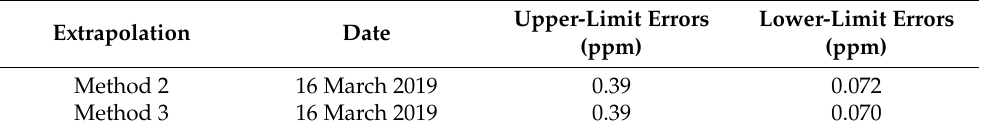
Table 6. The estimation of uncertainty for OCO-2 induced by extrapolation Method 2 (GEOS-Chem CO 2 profiles) and Method 3 (CarbonTracker